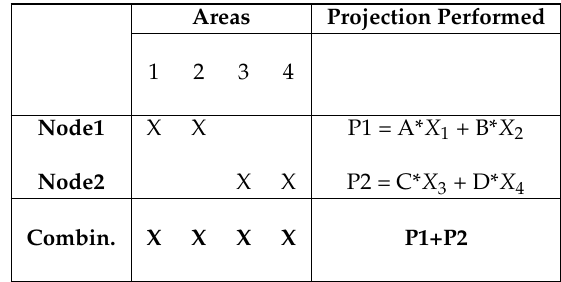
Table 2. CS: the combination of projections is possible because they do not overlap.